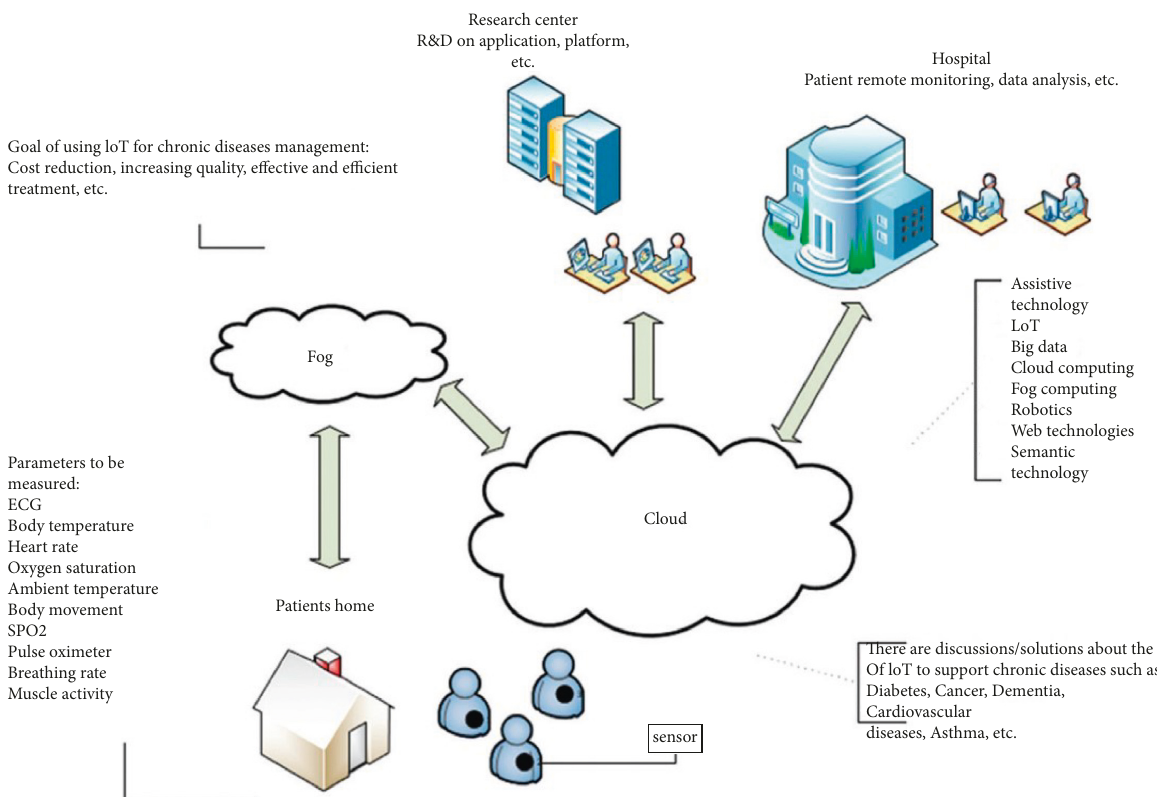
Figure 9: Management frameworks for chronic diabetes includes IoTsensors, laboratory tests, fog computing, cloud computing, and further research